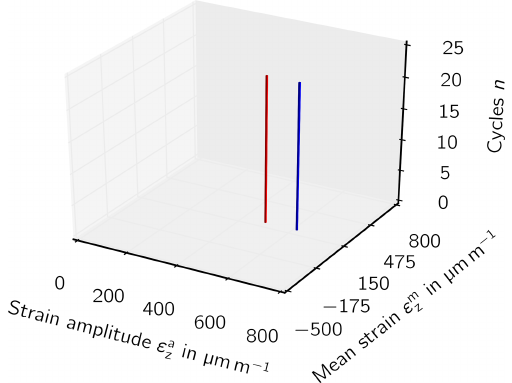
Figure 7. Markov matrix of a 600s static simulation at z = 10 . 2m and v = 9ms − 1 . The red bar stands for a load factor of γ l = 1 . 0 and the blue bar for γ l = 1 .